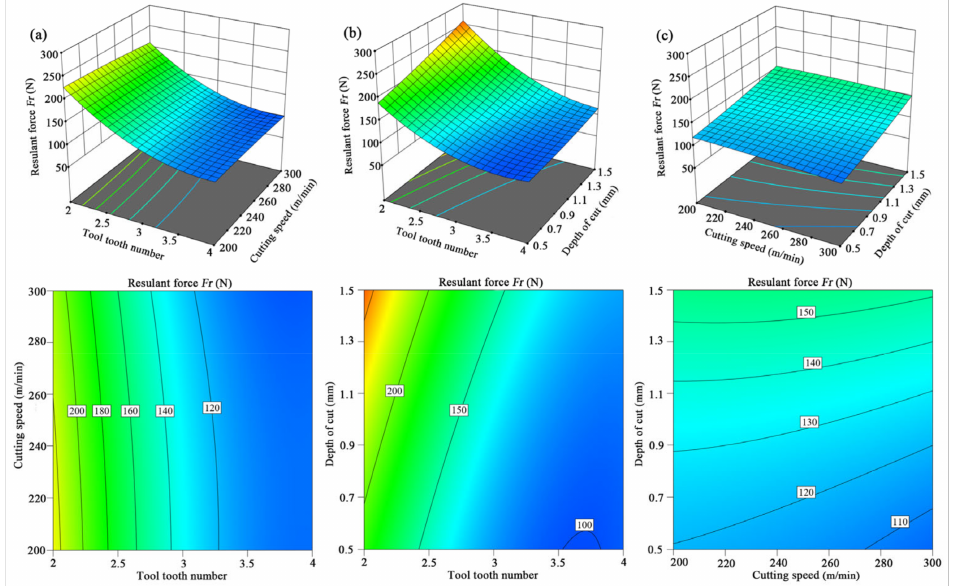
Figure 6. Three-dimensional surface and contour maps of resultant force ( a ) tool tooth number and cutting speed, ( b ) tool tooth number and depth of cut, and ( c ) cutting speed and depth of